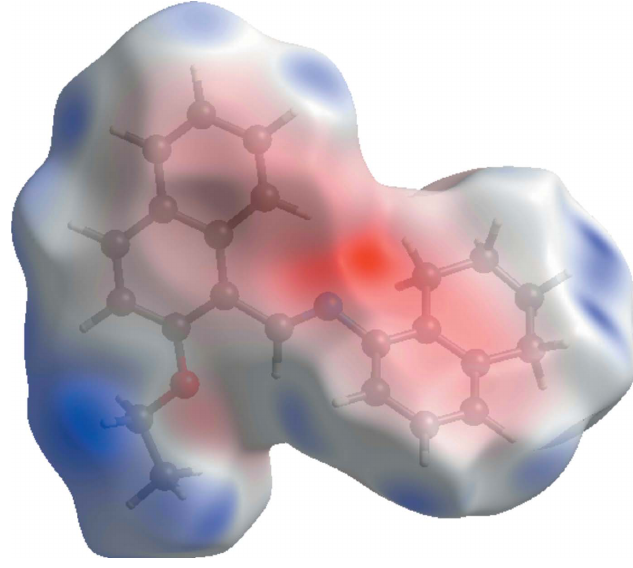
Figure 6 A view of the three-dimensional Hirshfeld surface plotted over electrostatic potential energy.